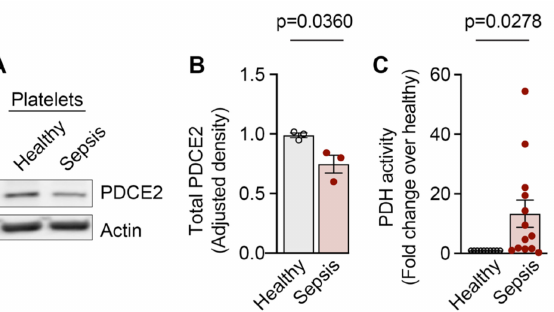
Figure 6. PDC-E2 protein levels and pyruvate dehydrogenase complex activity is increased in PLTs during sepsis. PLTs from healthy individuals and septic patients were isolated. ( A ) PDC-E2 protein expression levels were detected by Western blot. Position of PDC-E2 is marked. Correspond- ing actin (ACTB) is shown at the bottom and was used for the normalization of data presented in the bar graph shown in ( B ) below. This figure is representative of n = 3 independent experiments. Analyzed using t -test, p = 0.0360. ( C ) Pyruvate dehydrogenase complex activity assay was performed on PLTs isolated from septic (n = 13) and healthy (n = 11) individuals. Bar graph depicts mean optical signal ± SEM. Analyzed using t -test, p =